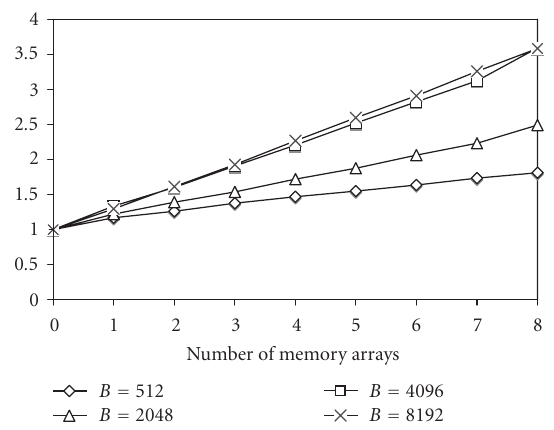
Figure 5: Impact on energy when increasing the number of mem- ory arrays (VPR Flow).